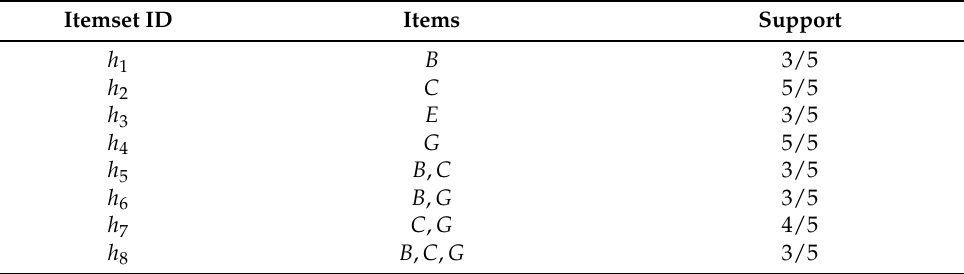
Table 2. Large itemsets, con minsupp = 3/5 =